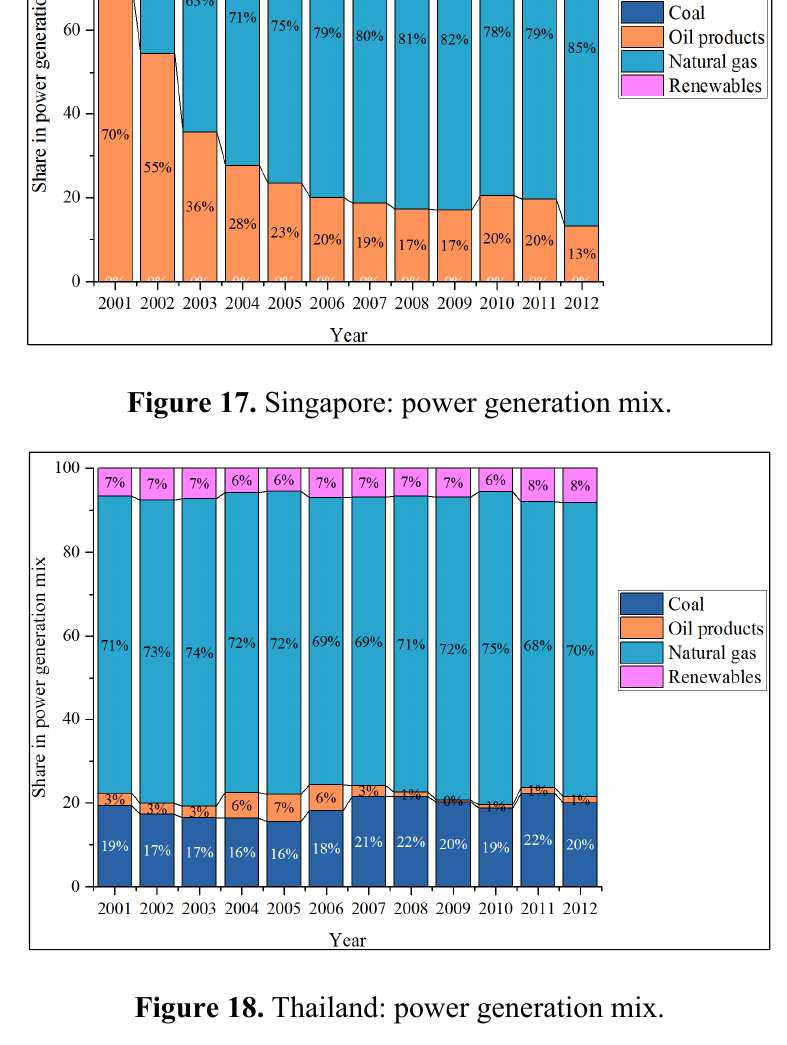
Figure 18. Thailand: power generation mix.